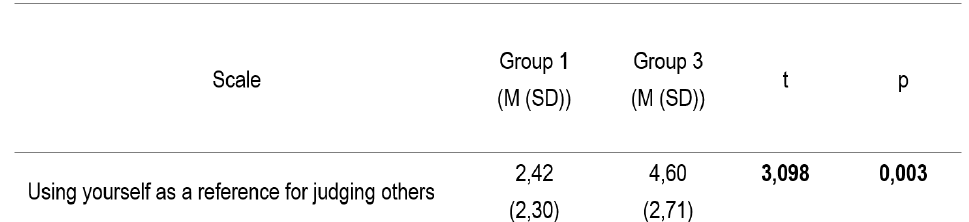
Indicators of communicative tolerance of mentors with high and low levels of success